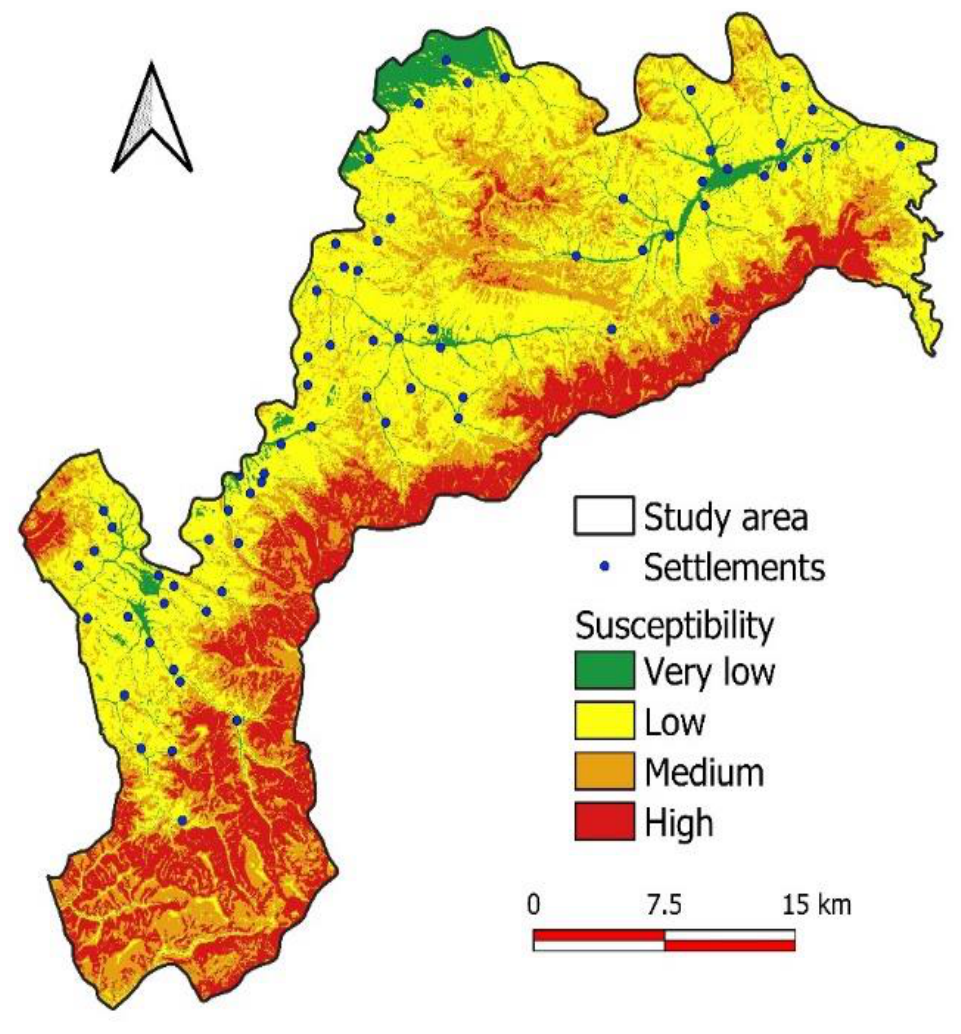
Figure 5. Snow avalanche hazard map. Table 13. Susceptibility of the terrain to snow